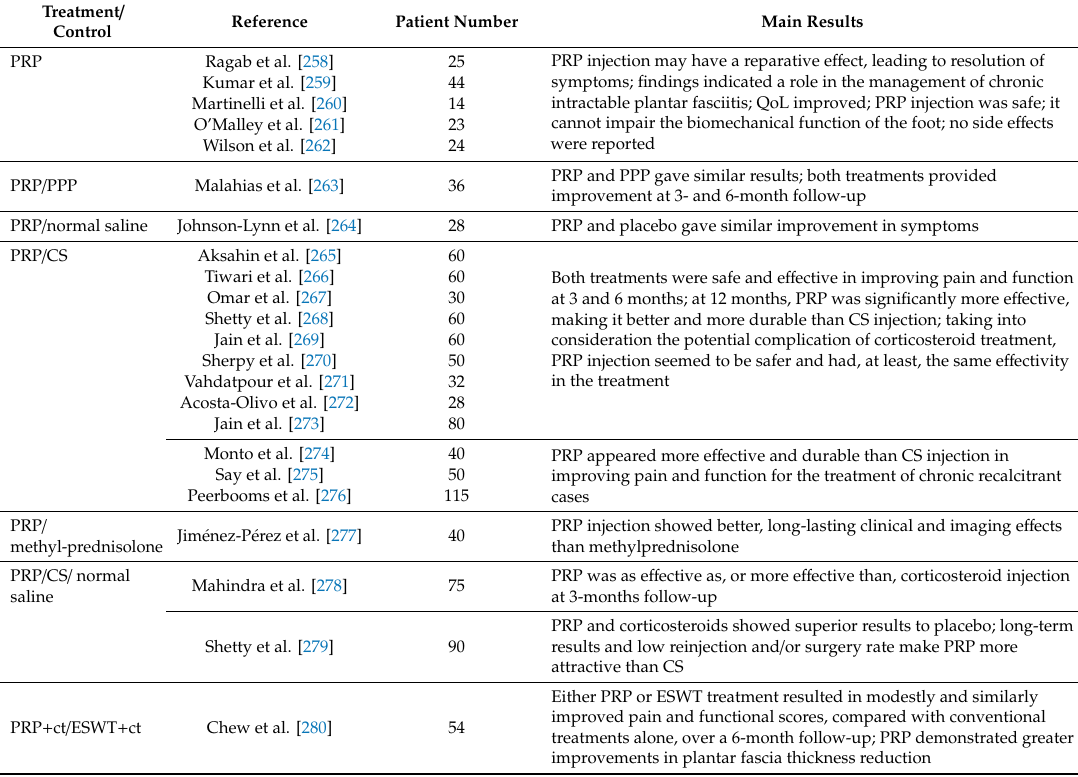
Table 7. Evidence of PRP treatment in plantar fasciitis (reported by year of study and treatment type). Treatment /